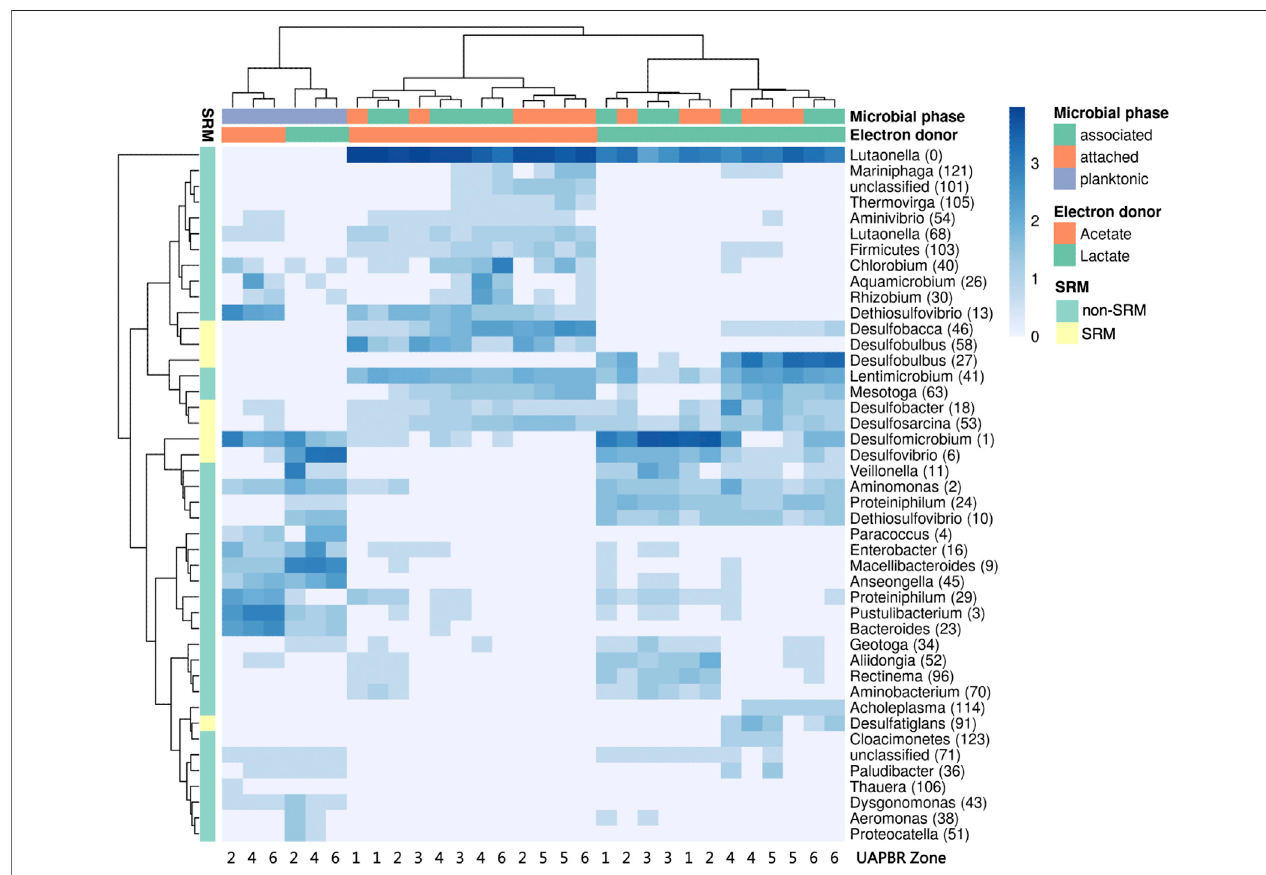
FIGURE9 | Hierarchical clustered heatmap oflog-transformed (ln x+1) relative abundances of predominant OTUspresentwithin thesubzones ofthe acetate- and lactate-supplemented UAPBR planktonic, associated and attached communities at steady-state at a one-day HRT. OTUs putatively identi fi ed as SRM based on taxonomy are